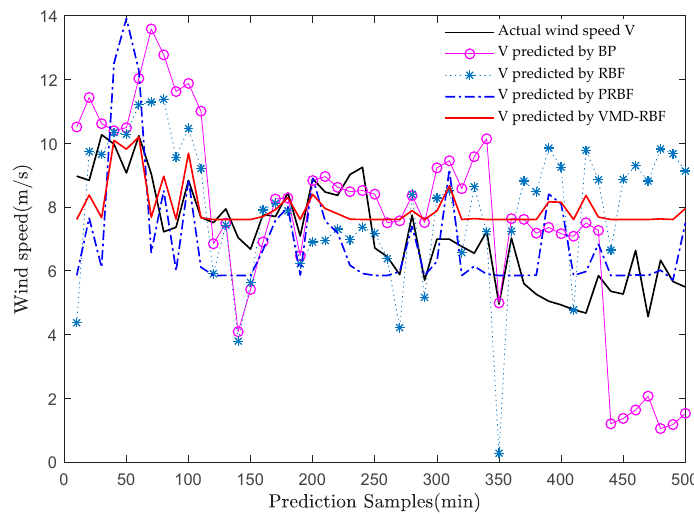
Figure 13. The results of comparison models (BP and RBF and PRBF and VRBF).